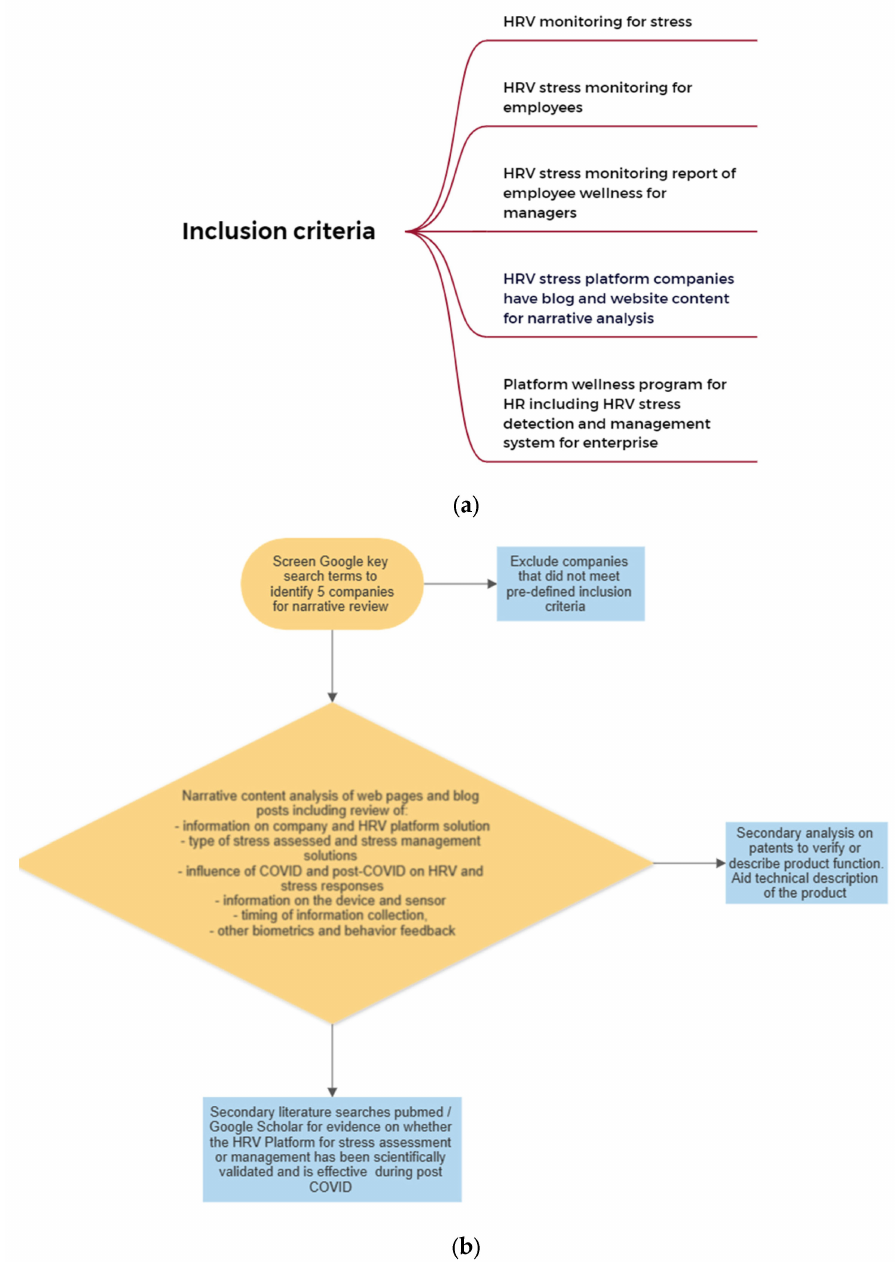
Figure 2. ( a ) Summary of inclusion criteria for selecting HRV stress platforms for analysis. ( b )